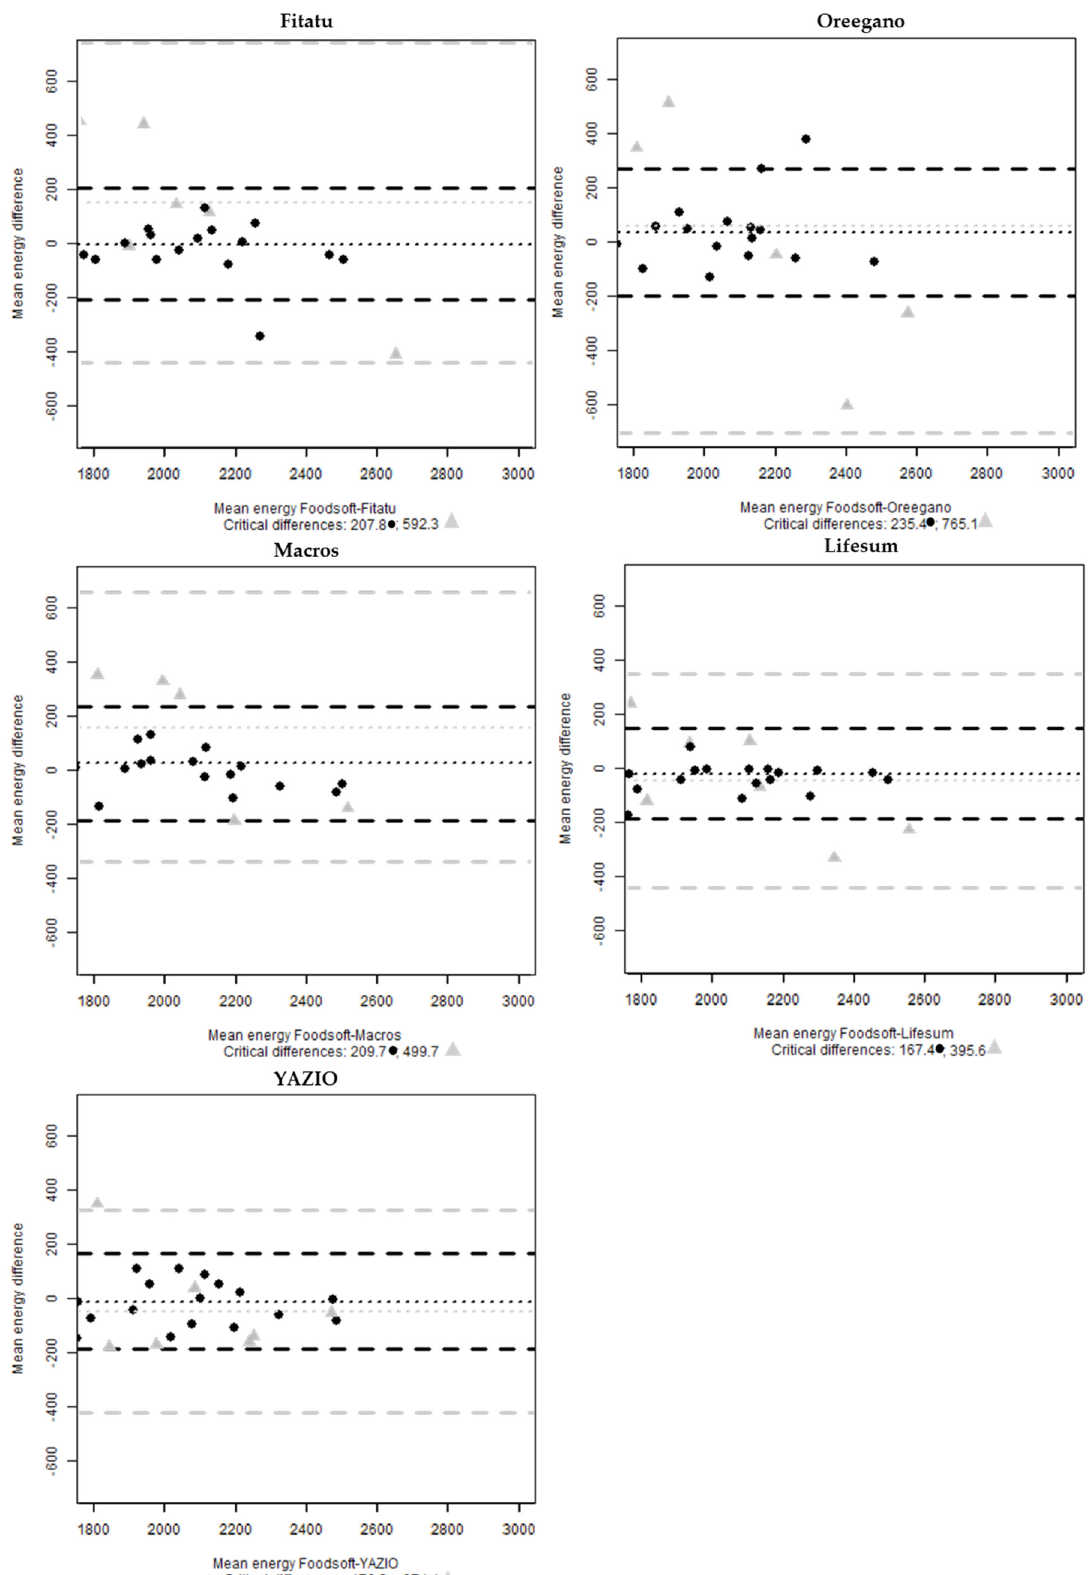
Figure 3. Bland-Altman plots of the mean energy (kcal) difference between Foodsoft 1.0 and Fitatu, Oreegano, Macros, Figure 5 . Bland-Altman plots of mean protein (g) difference between Foodsoft 1.0 and Fitatu, Oreegano, Macros, YAZIO YAZIO and Lifesum whole sample ( • ) and the selected 24-HRs ( and Lifesum whole sample ( ● ) and the selected 24-HRs ( ).